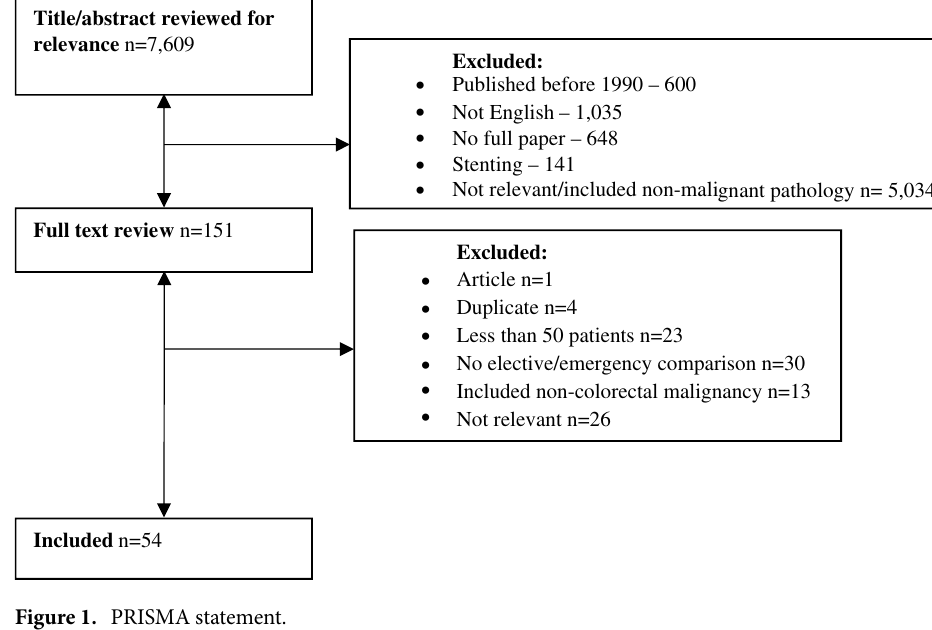
Figure 1. PRISMA